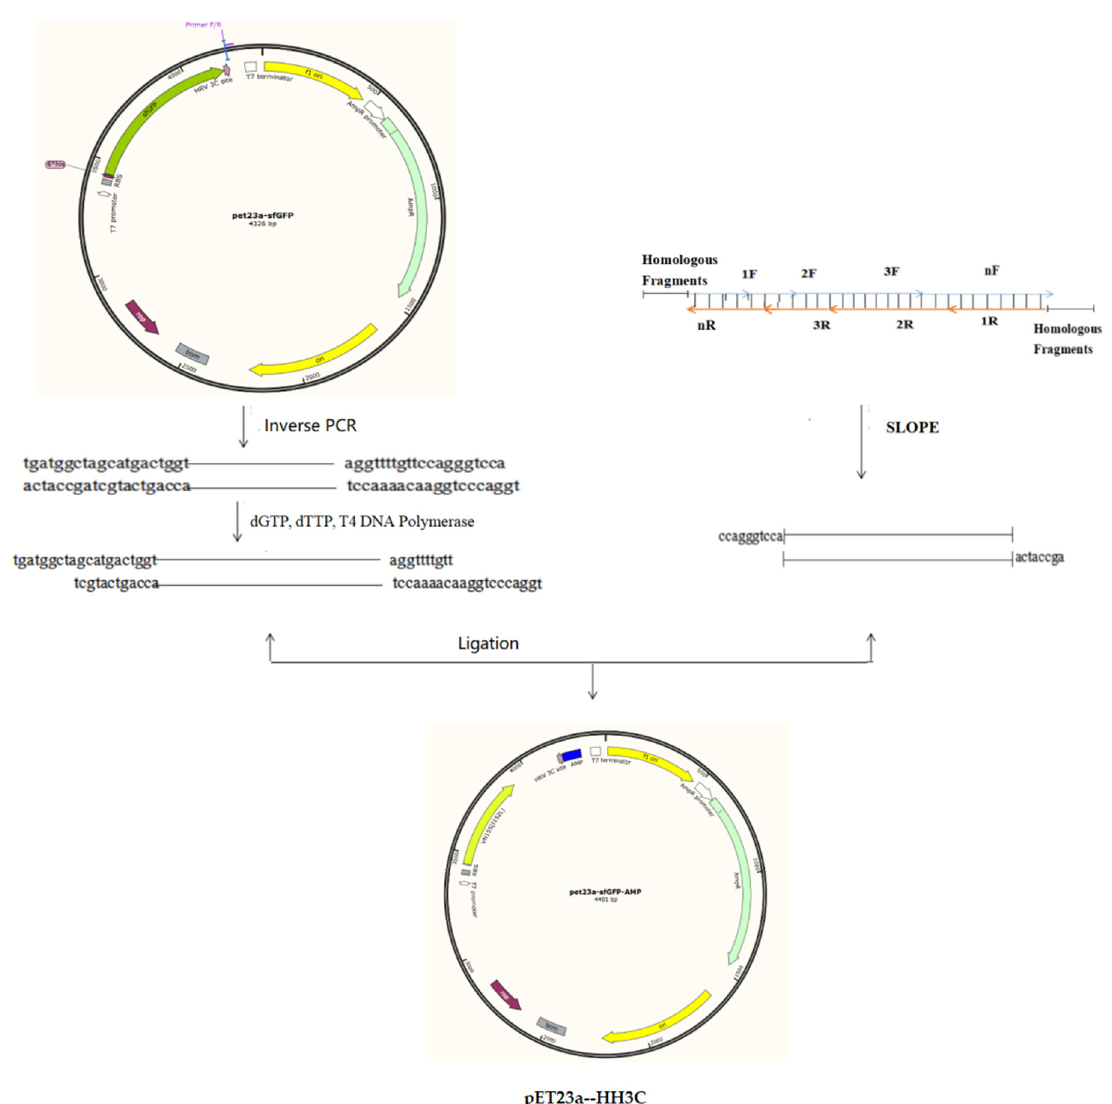
Figure 2. The construction of the AMP expression plasmids.